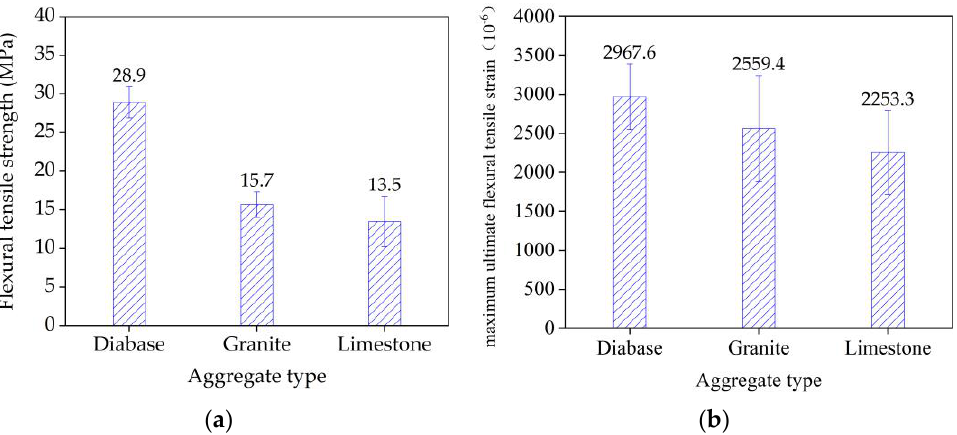
Figure 8. Three-point bending test results of three types of stone beams: ( a ) flexural tensile strength and ( b ) flexural tensile strain.